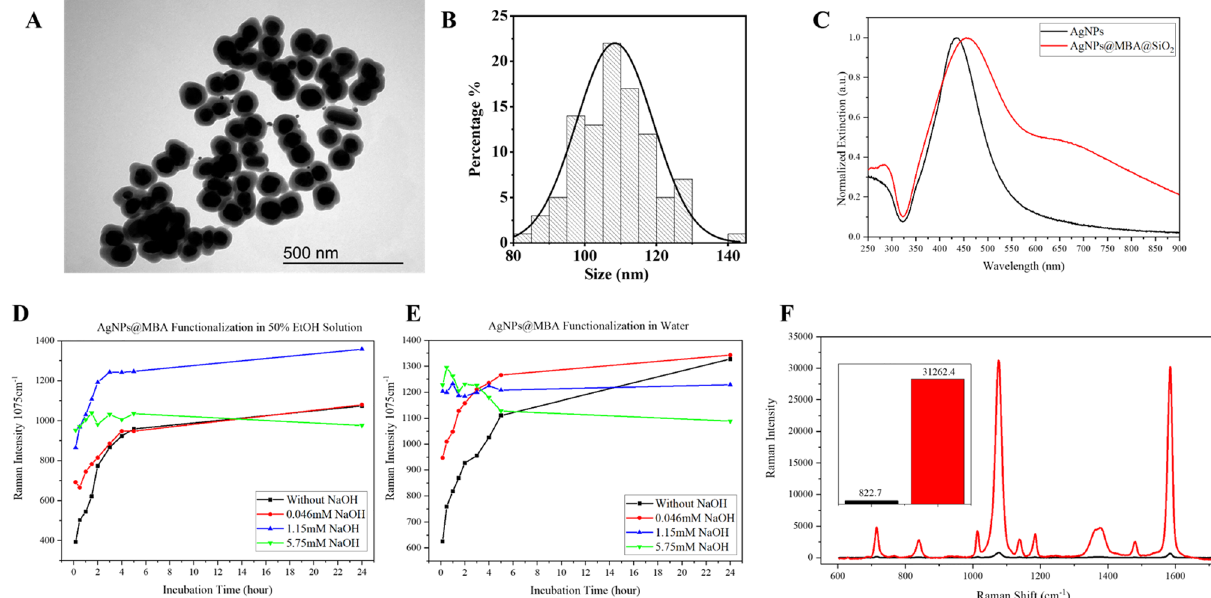
Figure 1. Synthesis and characterization of the SERS-responsive nanoagglomerates. ( A ) TEM image of AgNPs@MBA@SiO 2 . ( B ) Size distribution of AgNPs@MBA@SiO 2 based on the quantification of 100 NPs from TEM images. ( C ) UV–Visible extinction spectra of AgNPs (black) and AgNPs@MBA@SiO 2 (red). ( D , E ) MBA adsorption kinetic under different conditions (with or without NaOH) measured by SERS intensity at 1075 cm −1 ( D ) in 50% EtOH/water solution and ( E ) in aqueous solution. Black line: without NaOH; red line: with 0.046 mM NaOH; blue line: with 1.15 mM NaOH; green line: with 5.75 mM NaOH. ( F ) SERS spectra and SERS intensity at 1075 cm −1 (inset image) of non-agglomerated AgNPs@MBA@SiO 2 (in black), and nanoagglomerates, AgNPs@MBA@SiO 2 (in